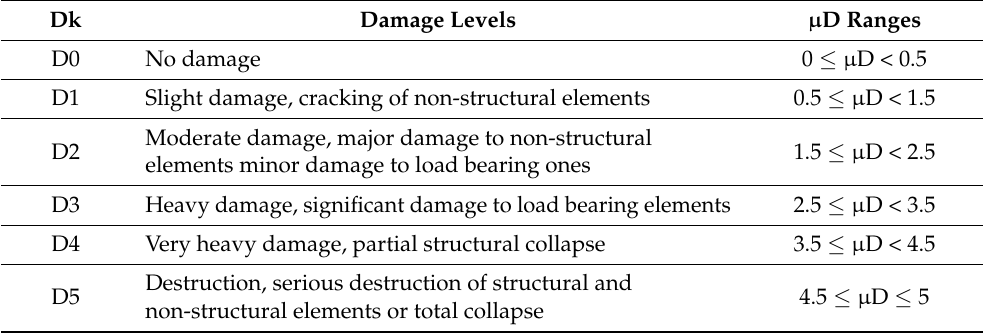
Table 8. Attribution of damage level Dk (k = 0–5) based on µ D ranges resulting from Equation